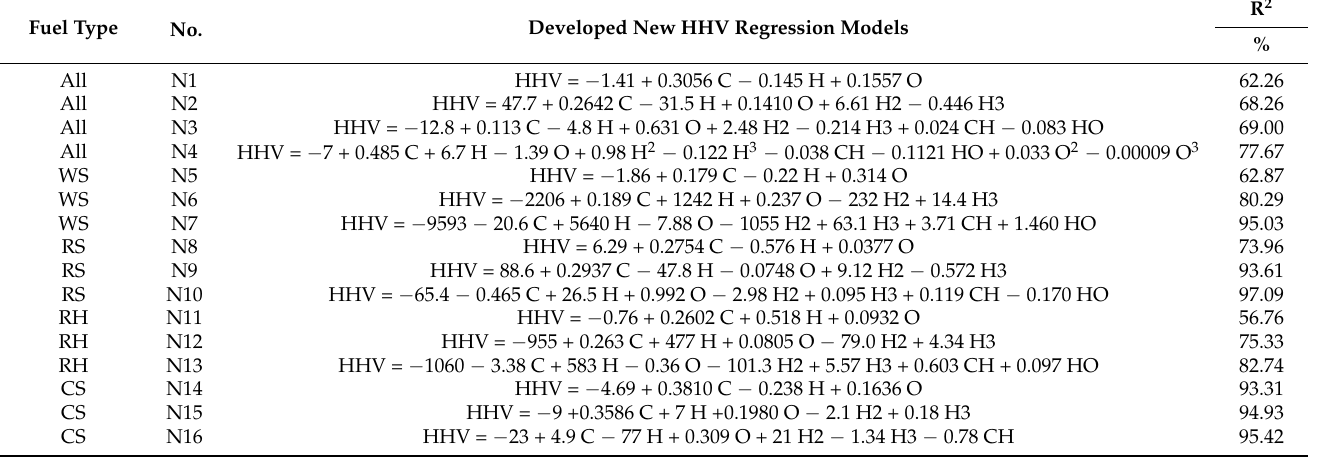
Table 6. Summary of developed linear and non-linear regression models for agricultural crop residues. Fuel